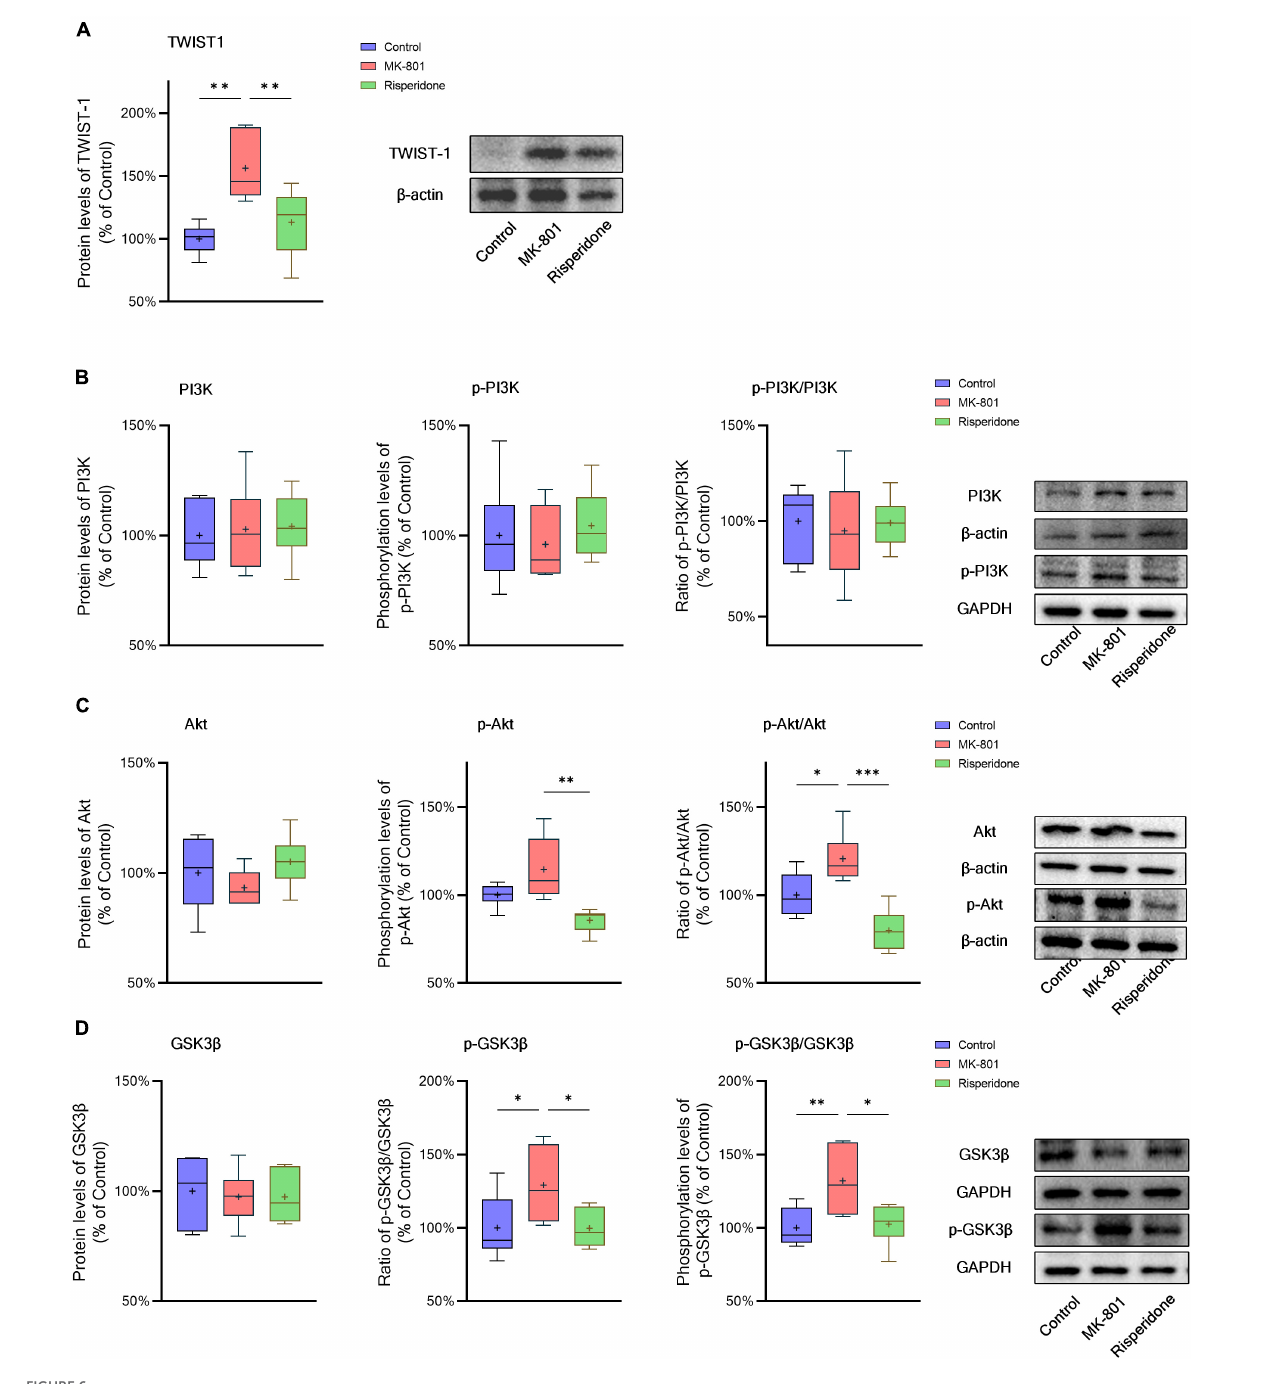
FIGURE6 Changed TWIST1/PI3K/Akt/GSK3 β signaling induced by the repeated MK-801 administration in the caudate putamen. (A) The protein levels of TWIST1 in the model rat caudate putamen (CPu) was reduced, but restored by risperidone. (B) The PI3K phosphorylation in the model rat CPu was not altered in the model rat CPu. (C) The phosphorylation of Akt in the model rat CPu was inhibited, but reversed by risperidone. (D) The GSK3 β phosphorylation was repressed by the MK-801 administration, but reversely affected by risperidone. ∗ P < 0.05, ∗∗ P < 0.01, ∗∗∗ P < 0.001, + mean